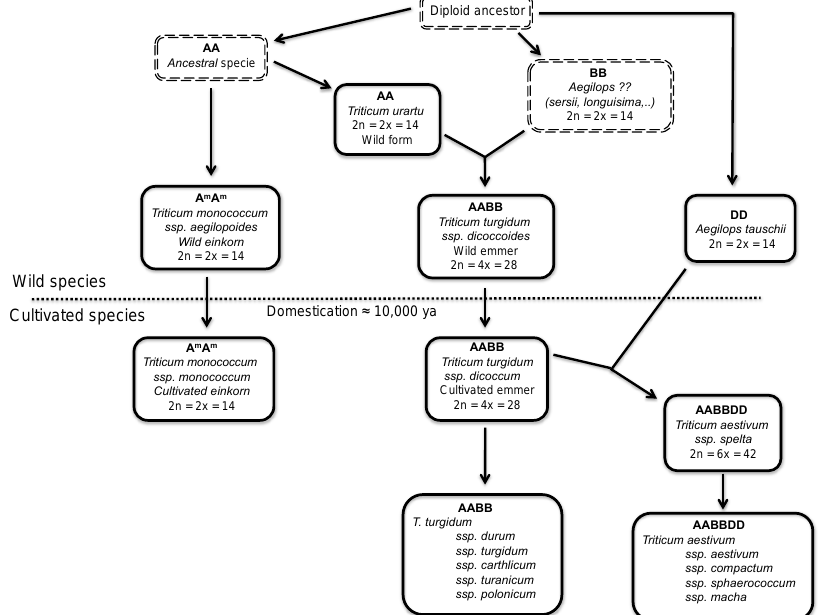
Figure 1. Diagram showing the evolutionary relationships among species of wheat and related species of Aegilops . The dotted line separates the wild and domesticated species of wheat. Ancestral or unknown species are surrounded by a double dashed rectangle. Ploidy level and the number of chromosomes are indicated. Nomenclature according to van Slageren